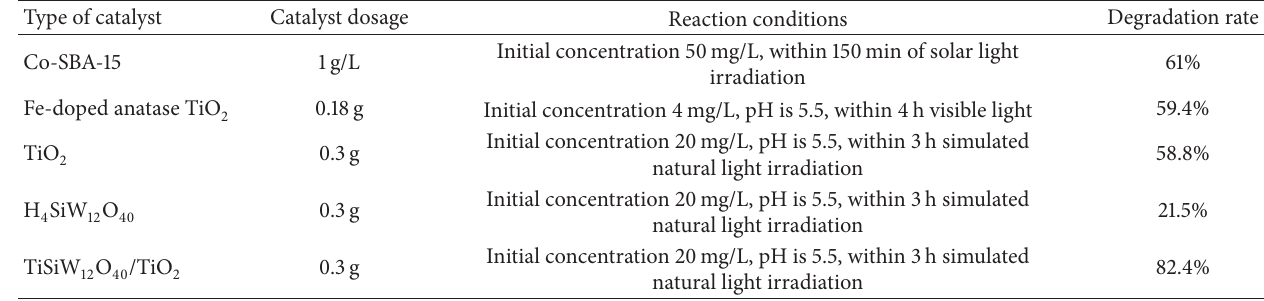
Table 1: Comparison of photocatalytic activity of